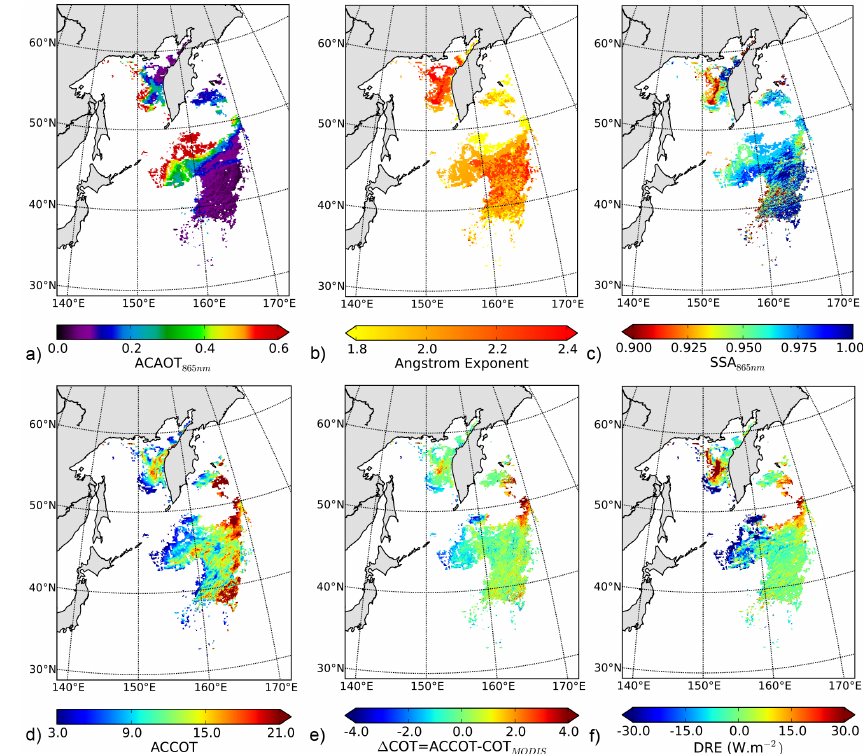
Figure 8. Same as Fig. 7 for biomass burning aerosols from Siberia on 3 July